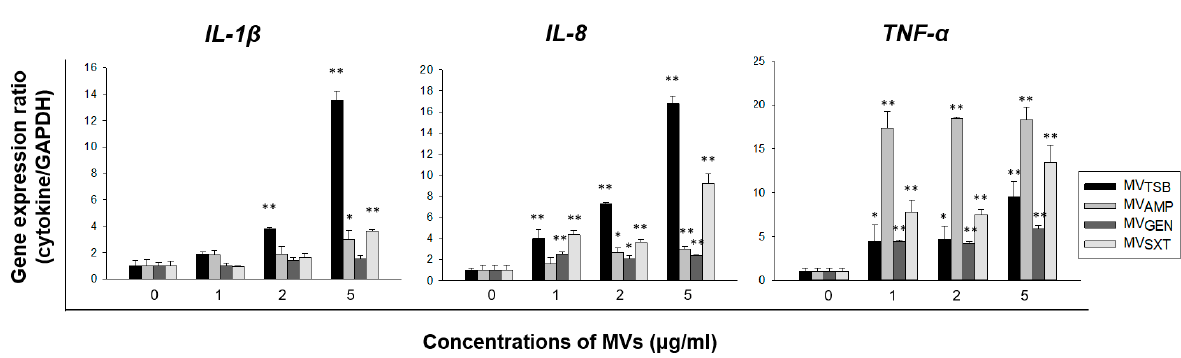
Figure 4. Expression levels of pro-inflammatory cytokine and chemokine genes in Caco-2 cells treated with L. monocytogenes MVs produced with or without antibiotics. Caco-2 cells were treated with various concentrations of L. monocytogenes MVs for 4 h. Gene expression was then assessed via qPCR. Data are presented as mean ± SD of three independent experiments. *, p < 0.05; **, p < 0.01 compared to untreated control cells.